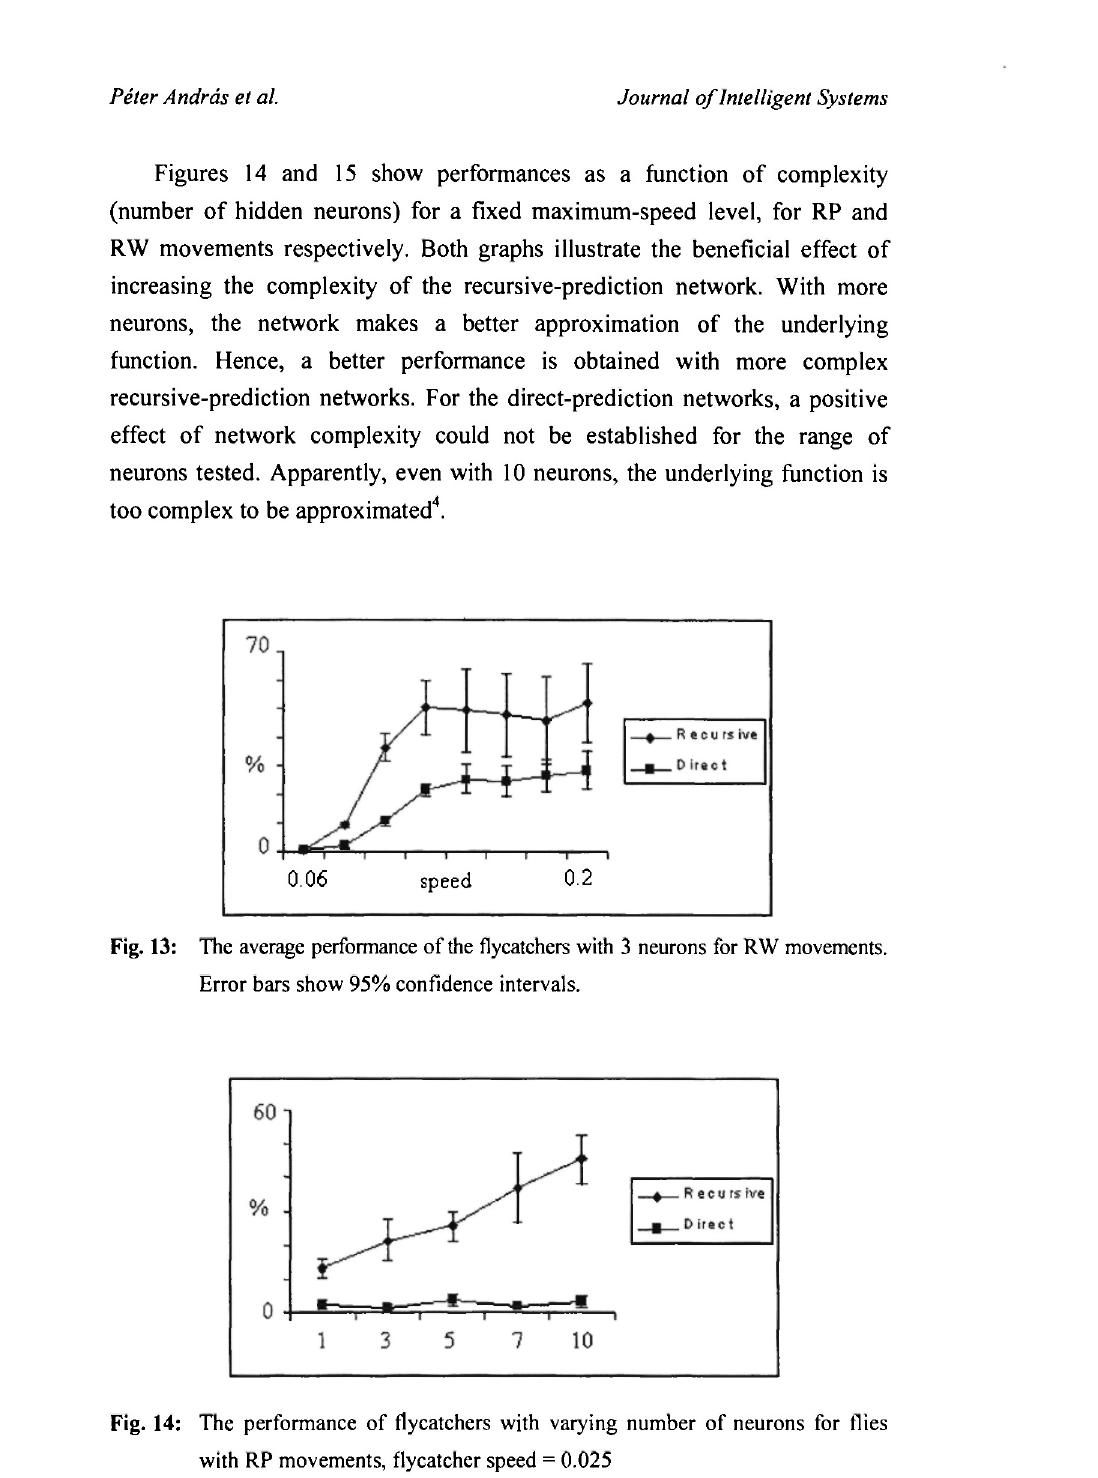
Fig. 14: The performance of flycatchers with varying number of neurons for flies with RP movements, flycatcher speed =